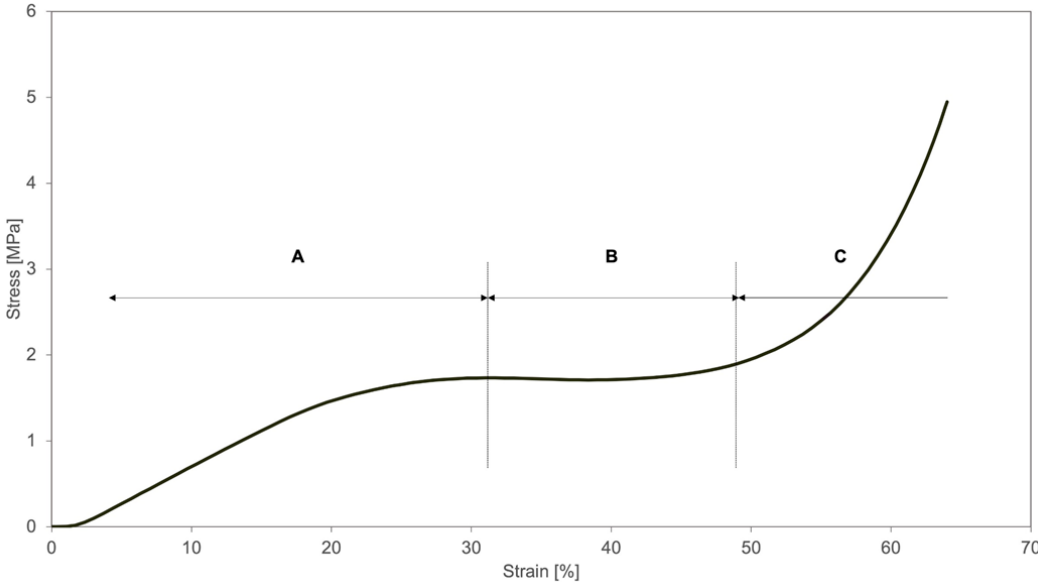
Figure 6. Typical zones of the behavior of the structures during the compression tests (in this case, the 50 % filling density is shown): A—elastic deformation of the material; B—small deformation of the structure with progressive collapse due to vertical walls buckling; C—full collapse of the structure with inherent densification (compression of a compact structure).